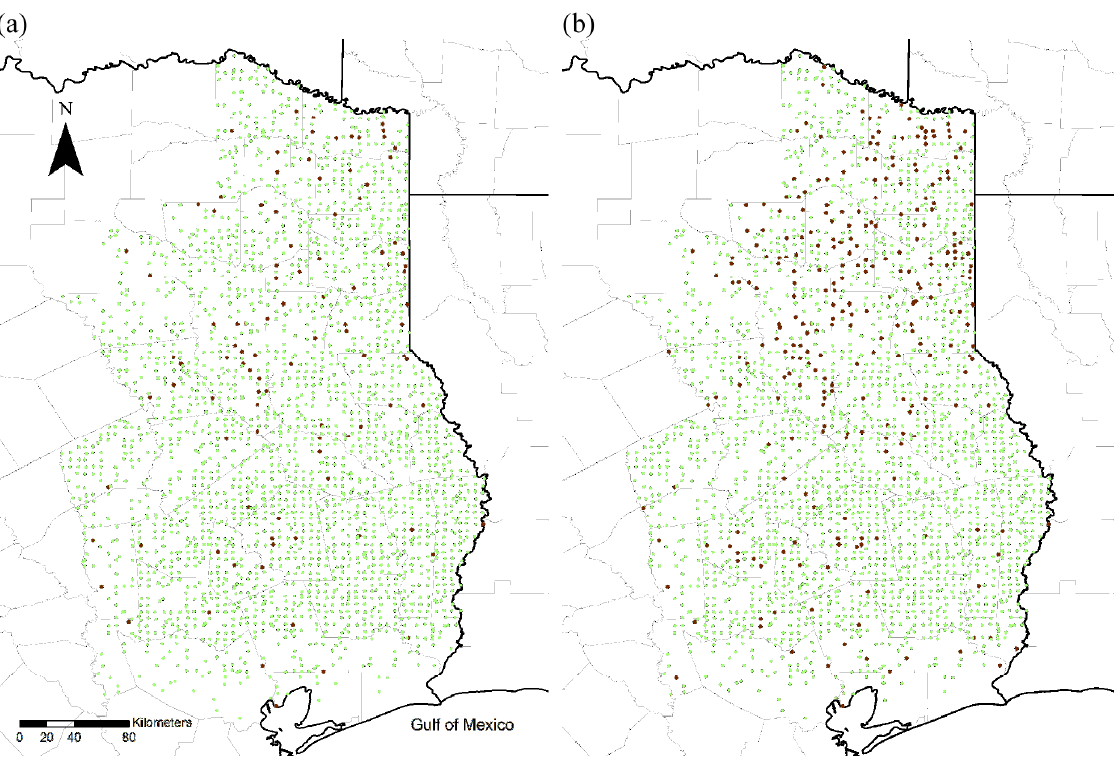
Figure 1. Presence (brown dots) and absence (green dots) of Chinese privet in plots sampled in Eastern Texas in ( a ) 2006 and ( b ) 2011 as part of the Forest Inventory and Analysis Program of the U.S. Forest Service [1].